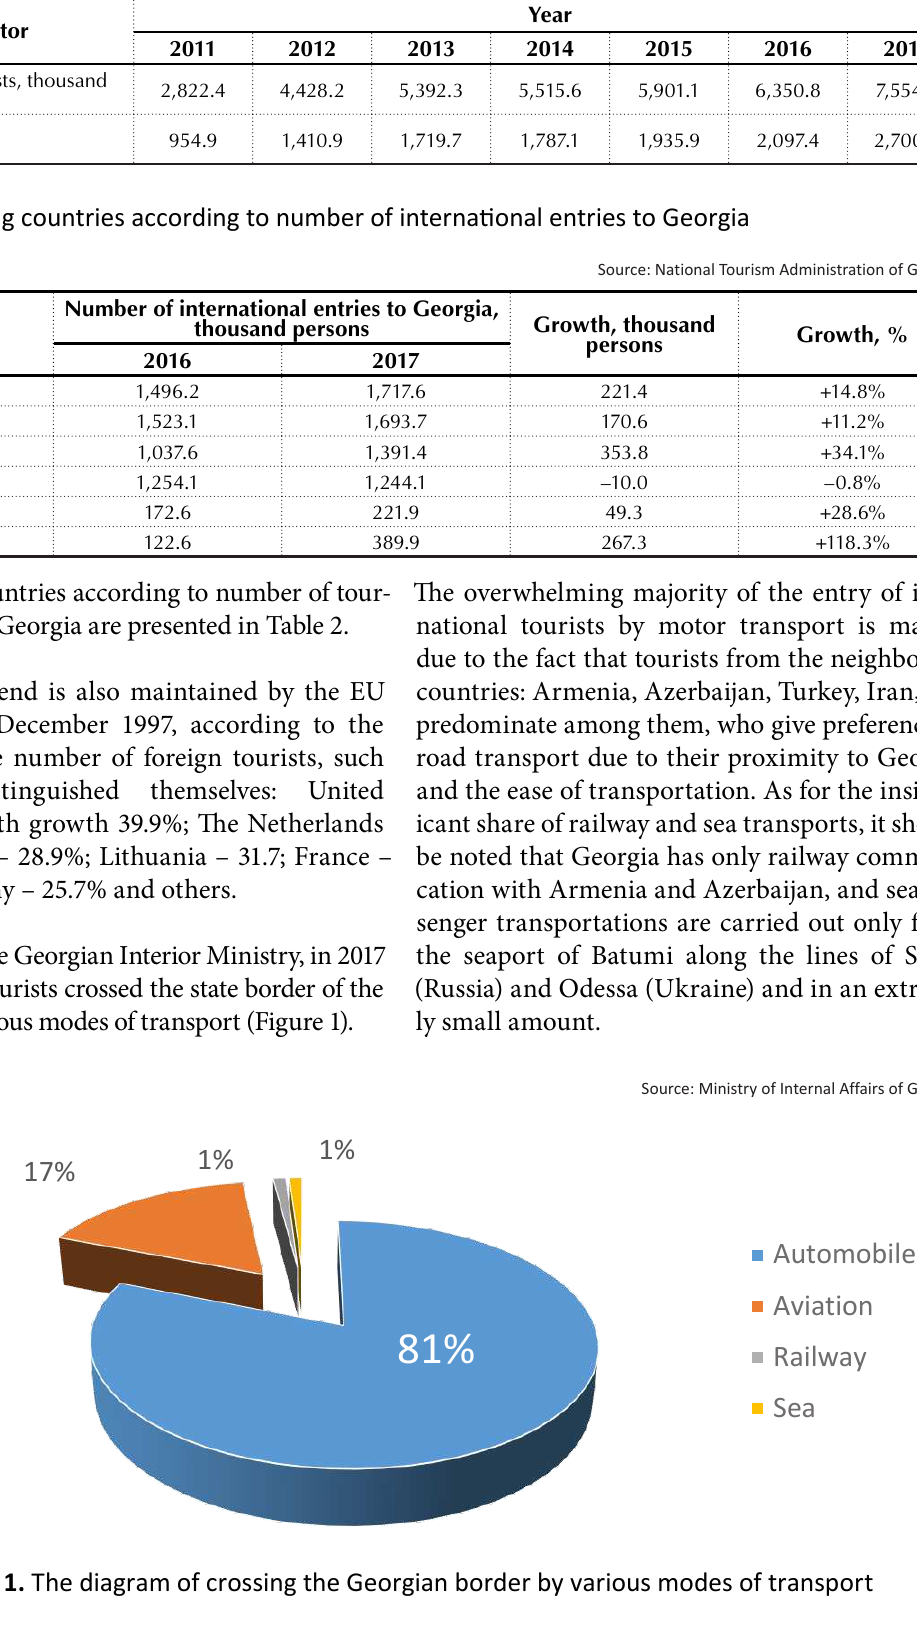
Table 1. Dynamics of the number of international tourists and tourism revenues in 2011–2016